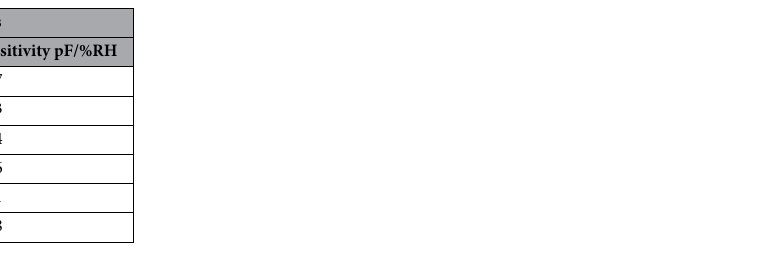
Table 3. Sensitivity of the transduction